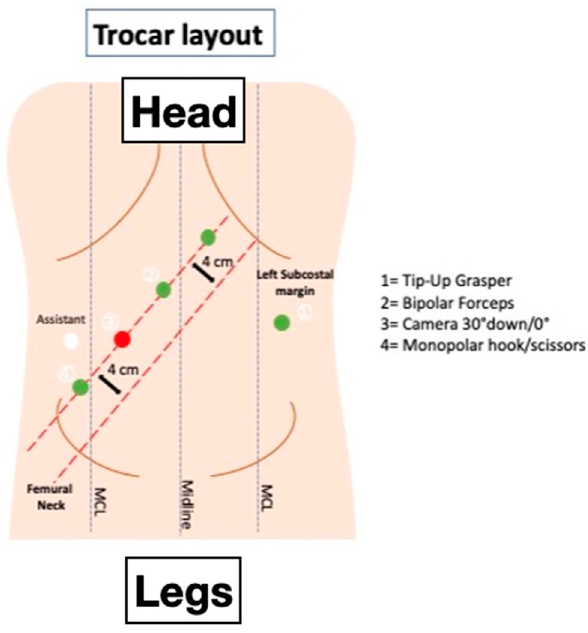
Figure 3. Trocar layout for a fully robotic TME.